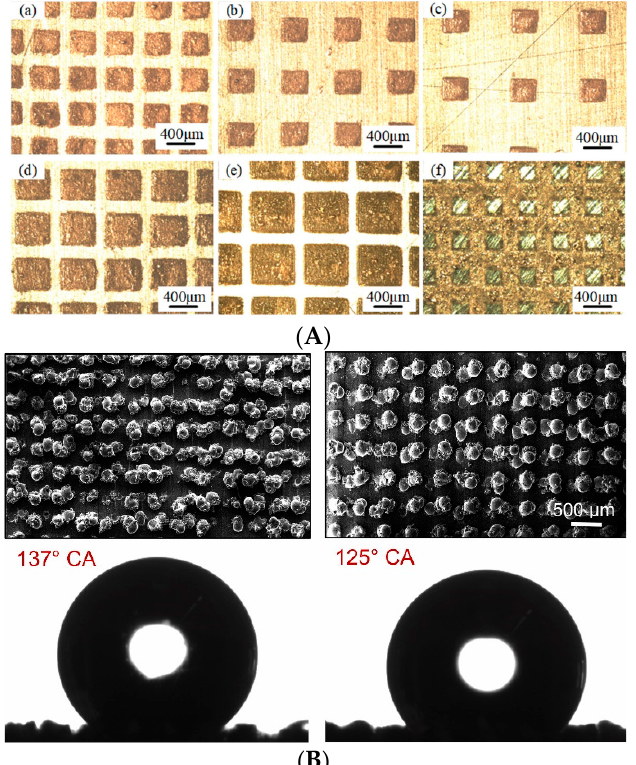
Figure 5. Examples of AM textures. ( A ): Various textures made of ink-printed copper nanoparticles. Reprinted with permission from Ref.[149]. Copyrights 2019 Elsevier. ( B ): Two cases of pillar array surfaces and the measured contact angle. Reprinted with permission from Ref. [150]. Copyrights 2021 Elsevier.